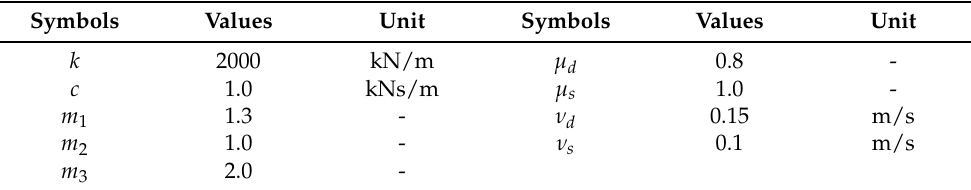
Table 2. Friction parameters.